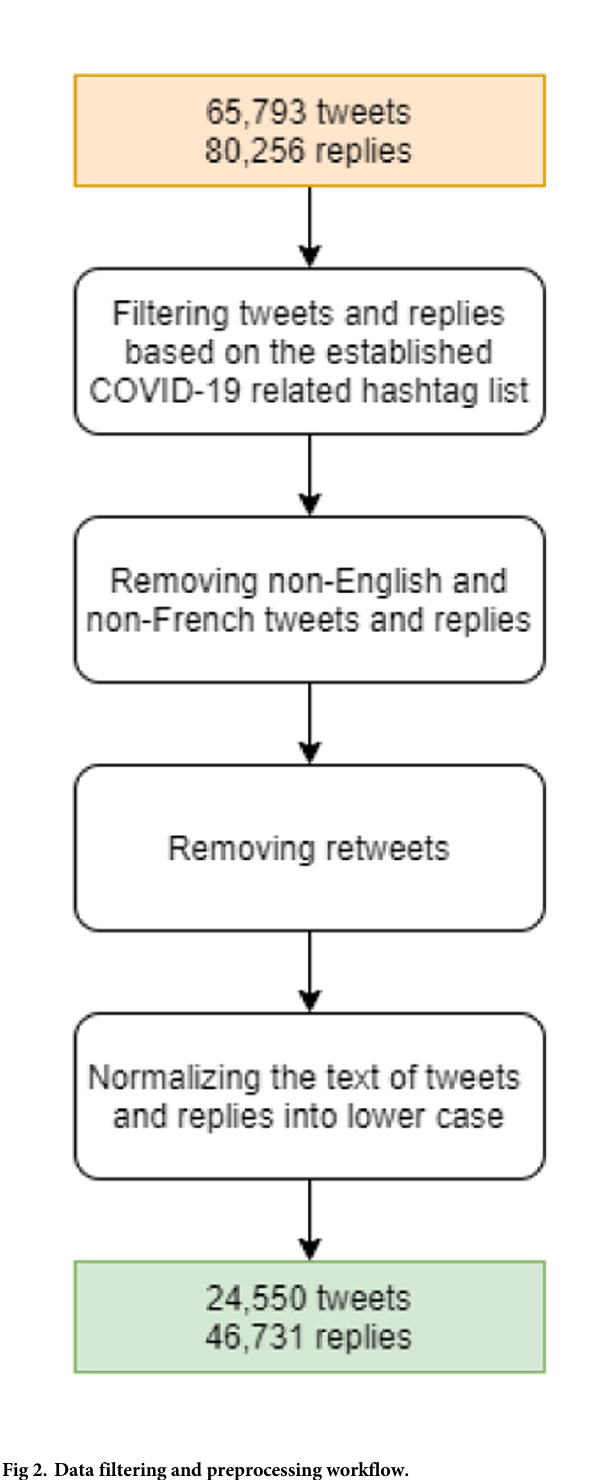
Fig 2. Data filtering and preprocessing